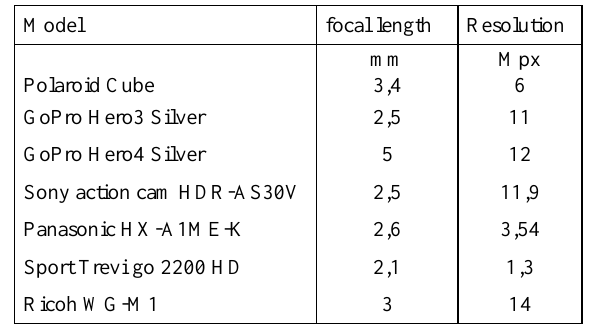
Table 1. Comparison of the focal length and resolution of some typical action camera.